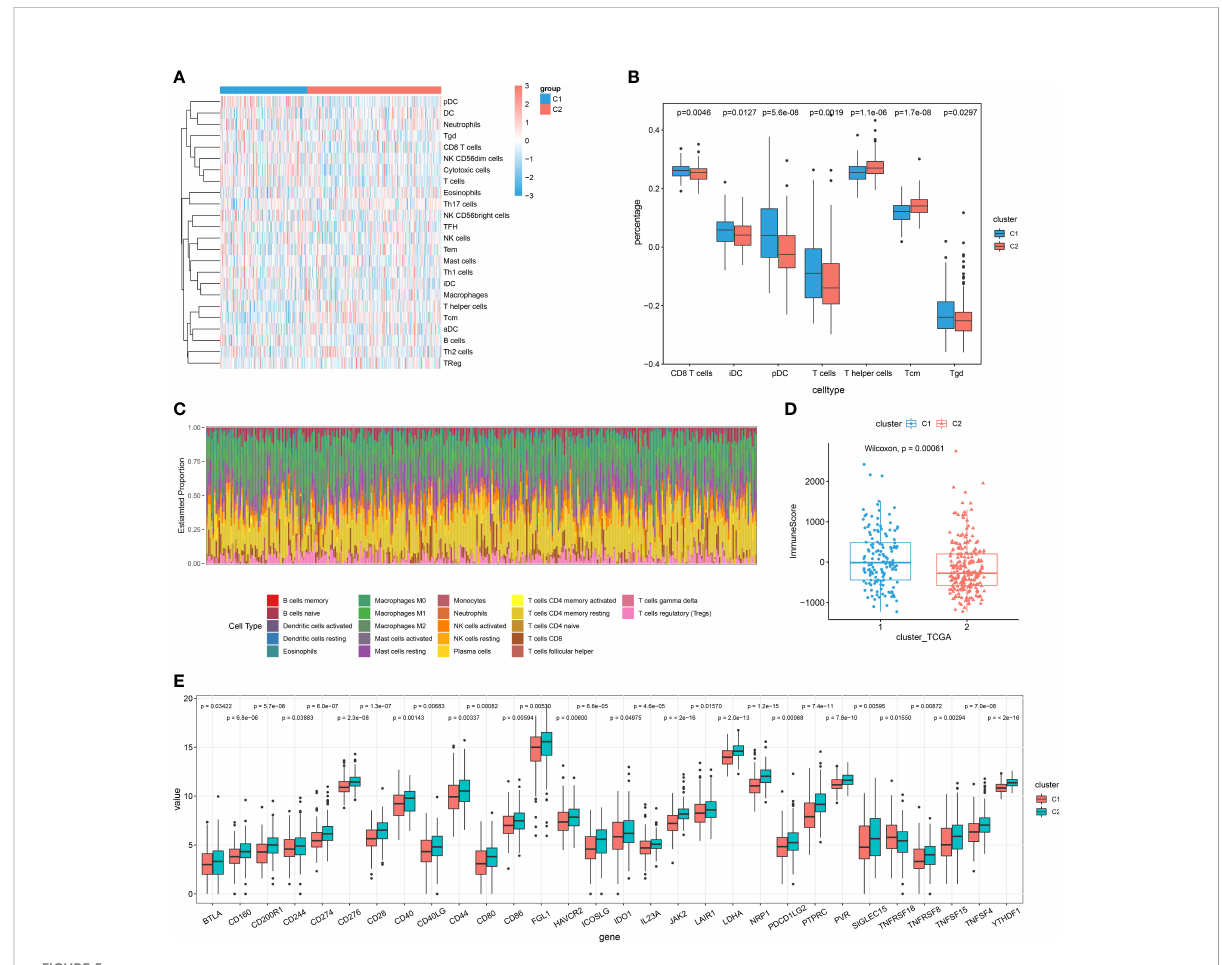
FIGURE 5 Cuproptosis patterns as characterized by different immune pro fi lers. (A) Enrichment levels of 24 immune-related cells in the cuproptosis-C1 and cuproptosis-C2 subtypes using ssGSEA. (B) Boxplots showing differences in cell type percent between immune patterns. (C) Histograms displaying the proportion of 22 different types of immune cells in patterns as based on CIBERSORT. (D) Boxplots showing estimated differences in immune scores. (E) Gene expression levels of 20 immune checkpoints between the two